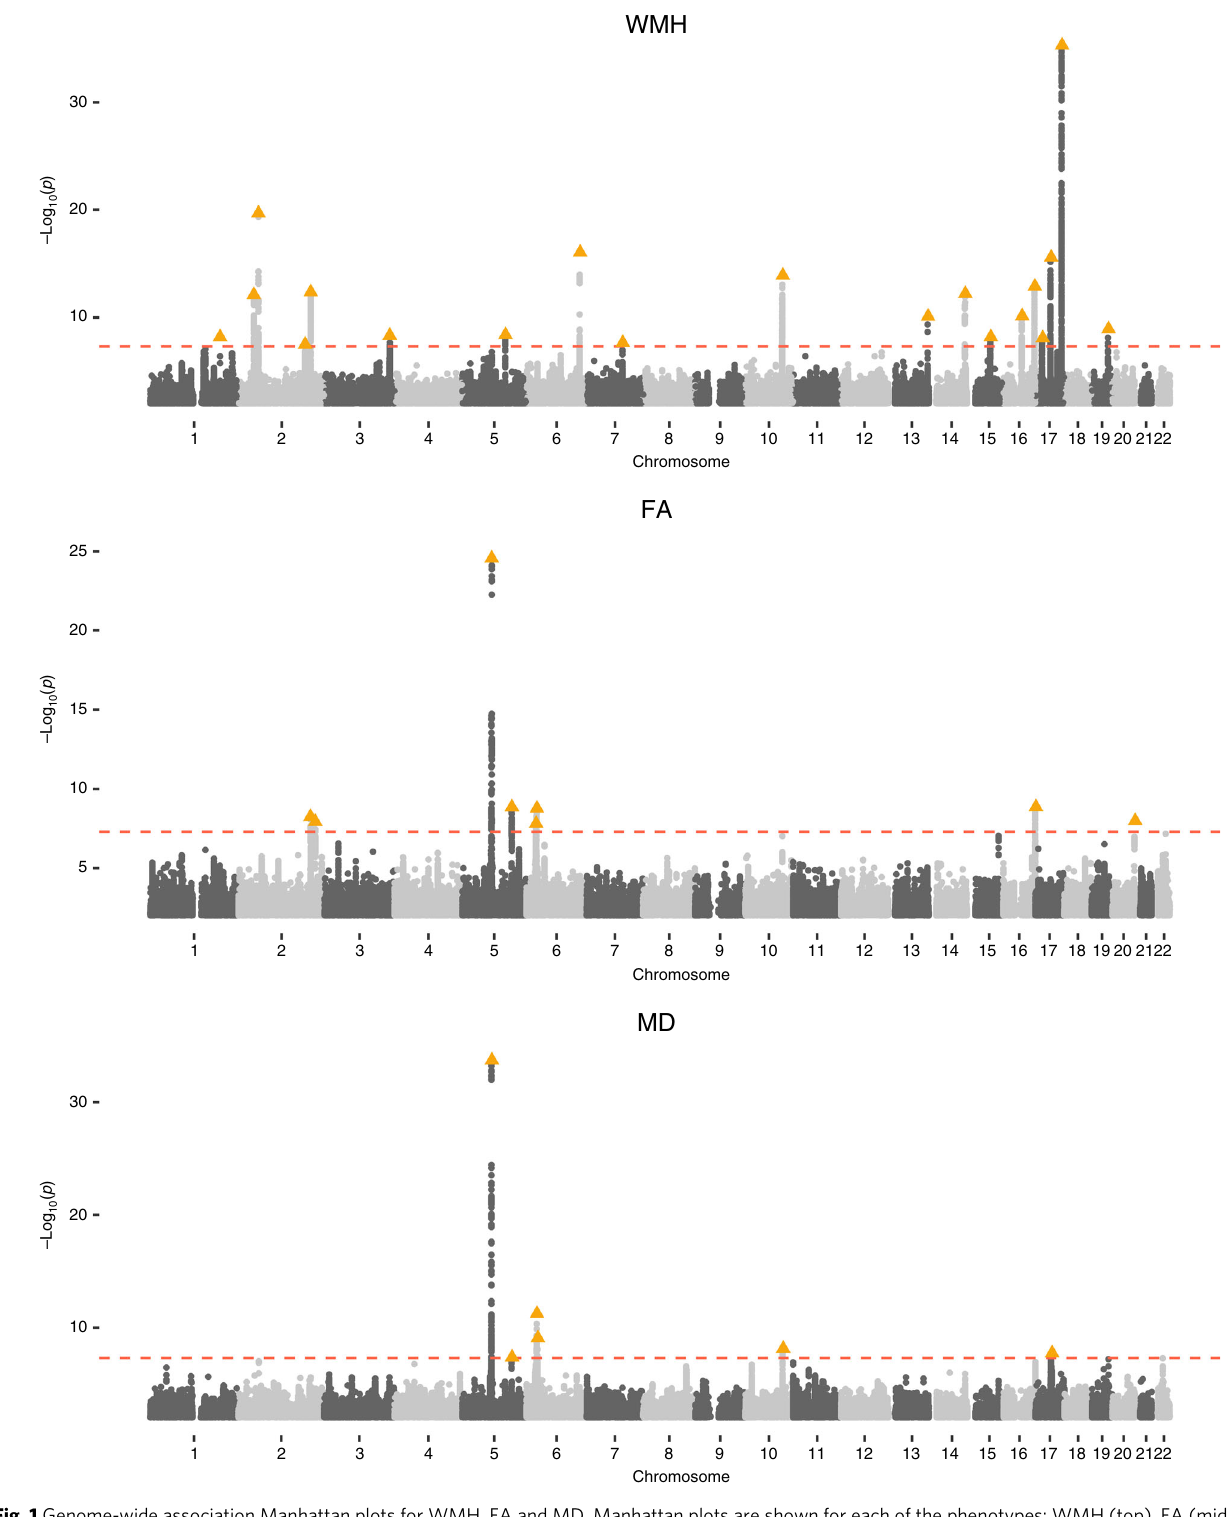
LDSC 18 and performed colocalization analysis on the associated loci (Fig. 2) 19 . SNP heritability estimates ( h 2 ) were 0.18 (se = 0.02) for WMH, 0.32 (se = 0.04) for FA and 0.27 (se = 0.04) for MD. There was strong evidence of genetic sharing between WMH, FA and MD